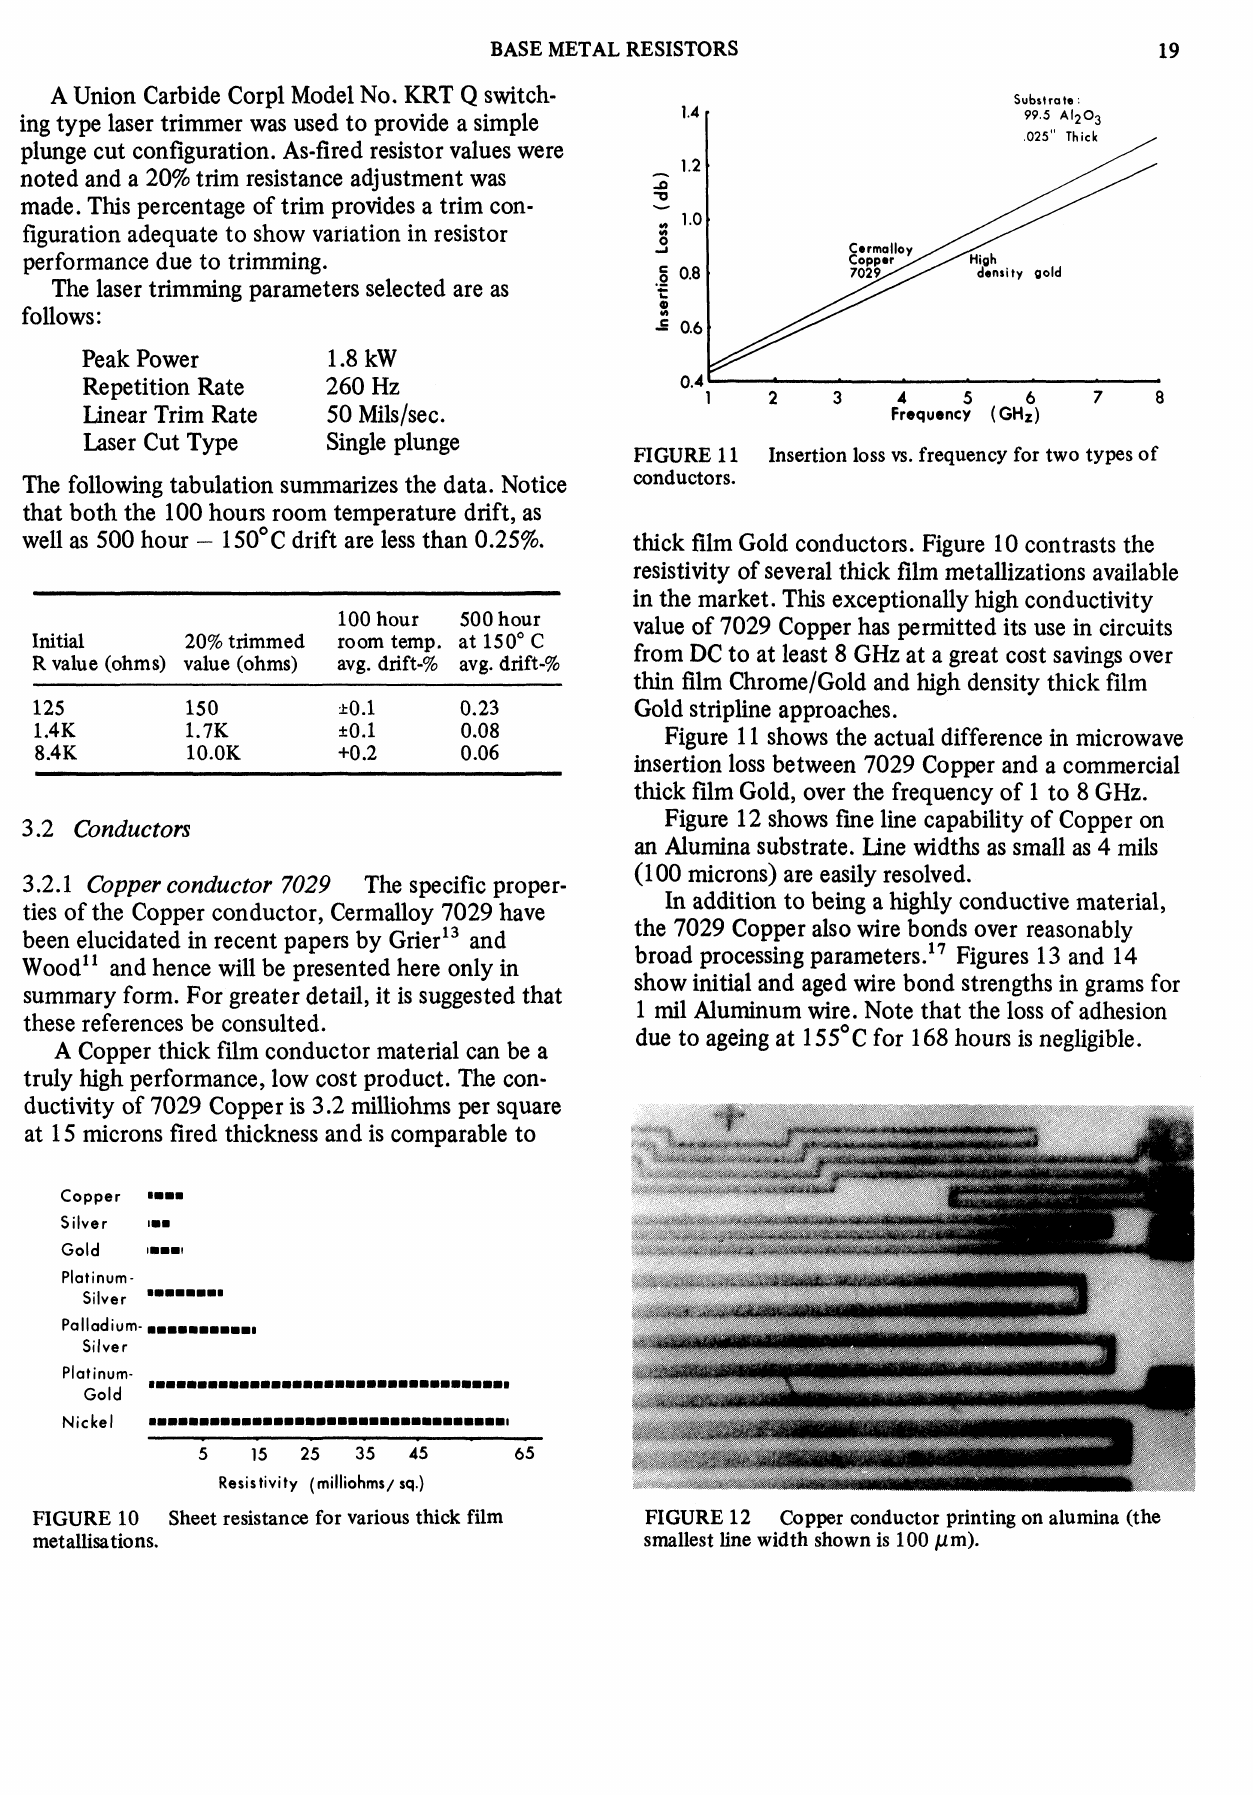
FIGURE 10 Sheet resistance for various thick film metallisations.